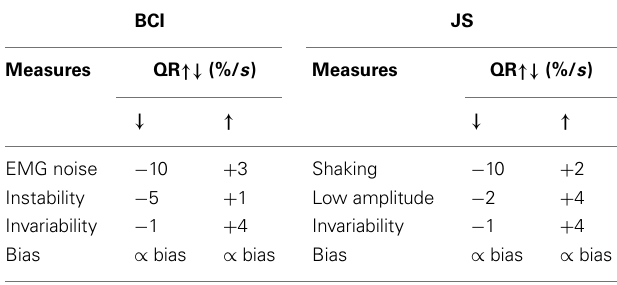
Table 1 | BCI and JS quality